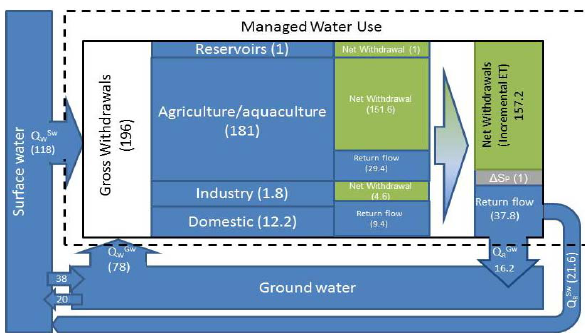
Figure 6. WA+ withdrawal sheet for the Indus basin based on 2007 data. All components are in 3 Fig. 6. WA + withdrawal sheet for the Indus basin based on 2007 km 3 4 data. All components are in km 3